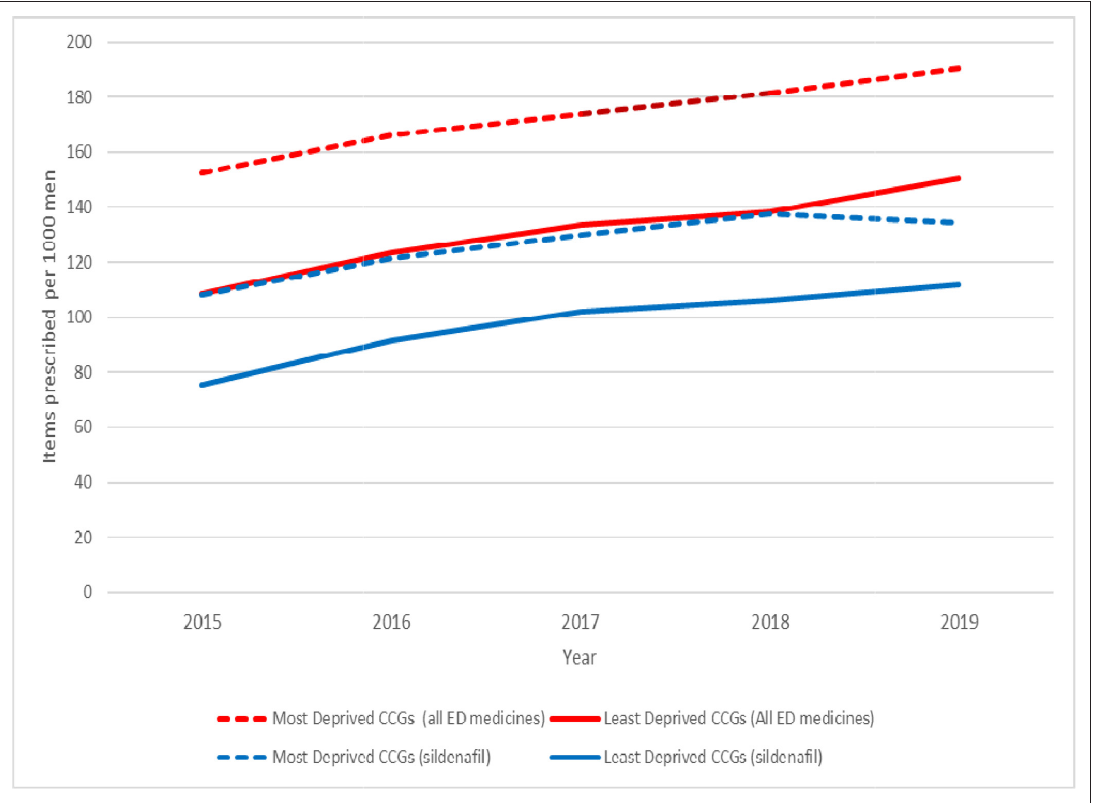
Figure 2 The number of items of ED medicines prescribed annually in the most and least deprived CCGs in England. CCG = clinical commissioning groups. ED = erectile